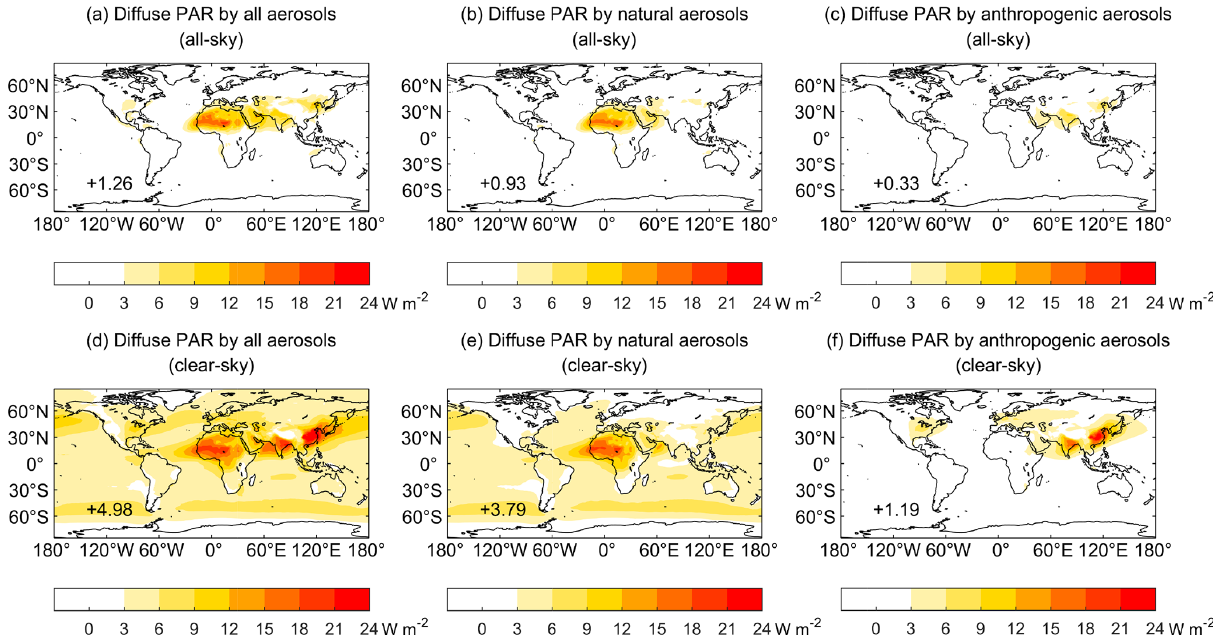
Figure 2. Global annual changes of diffuse PAR at the surface by all, natural, and anthropogenic aerosols under all-sky conditions (a–c) and clear skies (d–f) . The aerosol species include natural (BC, OC, dust, sea salt, sulfate, and nitrate) and anthropogenic (BC, OC, sulfate, and nitrate) aerosols. The total changes in PAR caused by different aerosol sources are shown on corresponding panels. Changes of diffuse PAR caused by individual aerosol species are shown in Fig. S4. The units are Wm − 2 .